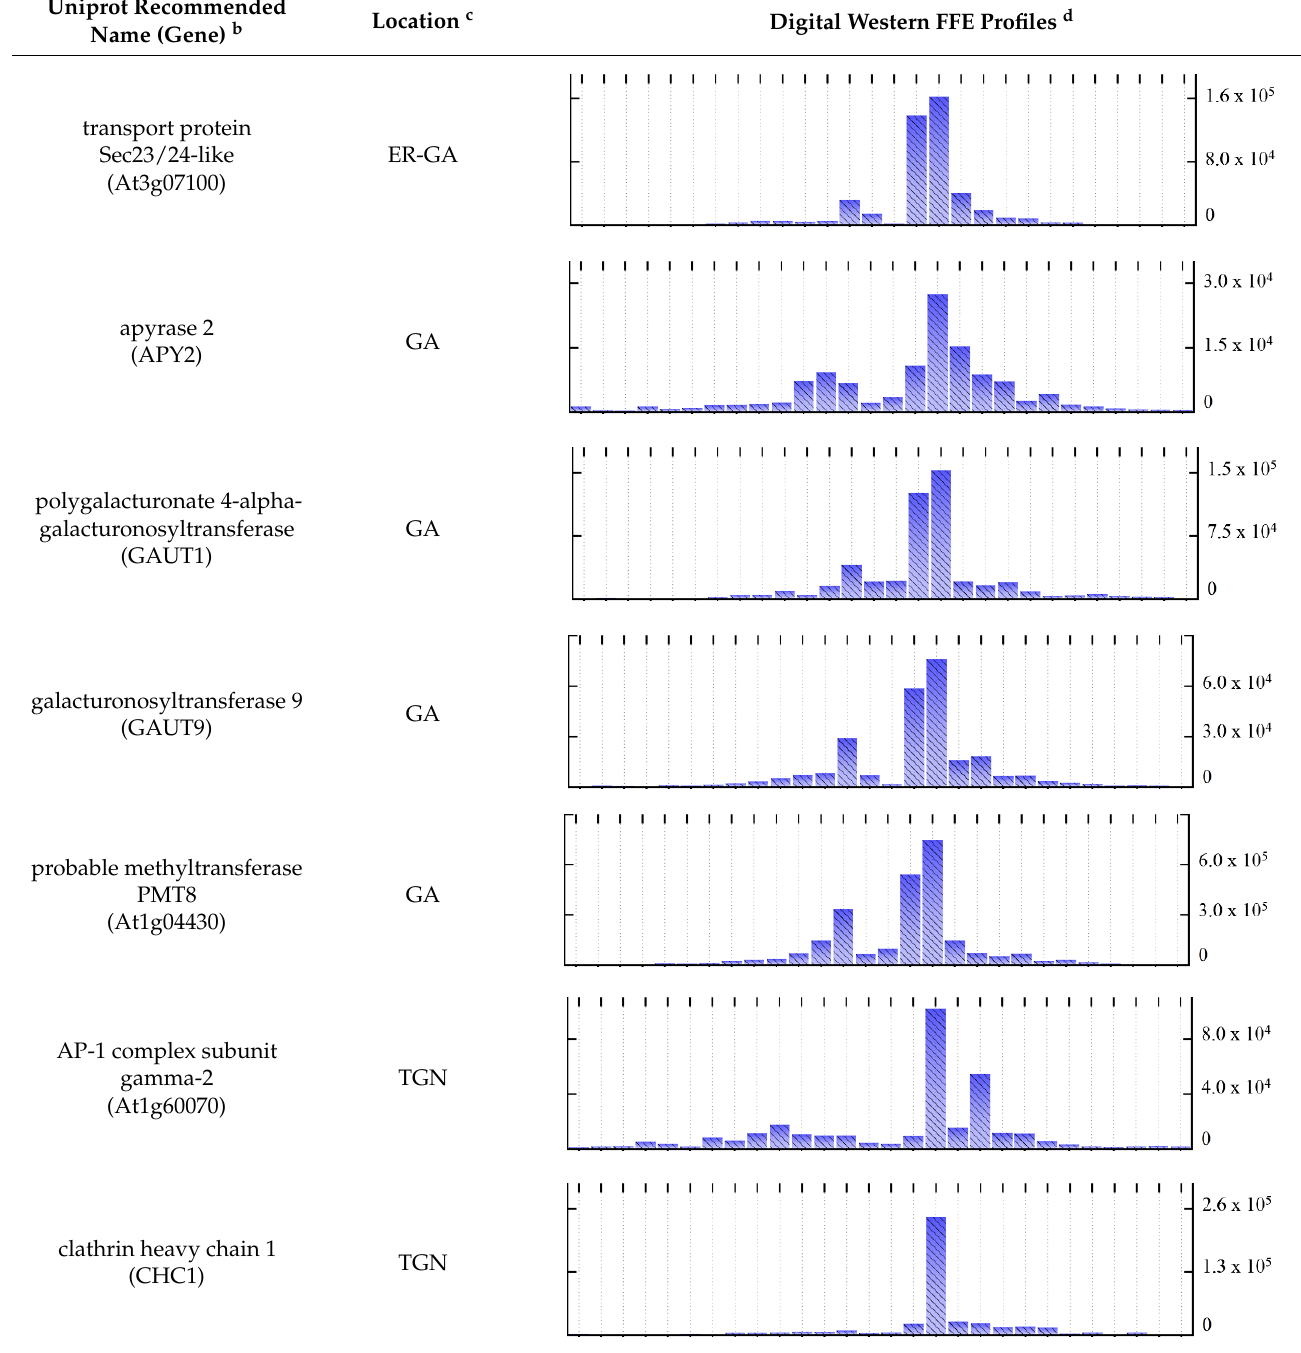
Proteins localized to chloroplast envelope membranes, such as inner/outer envelope